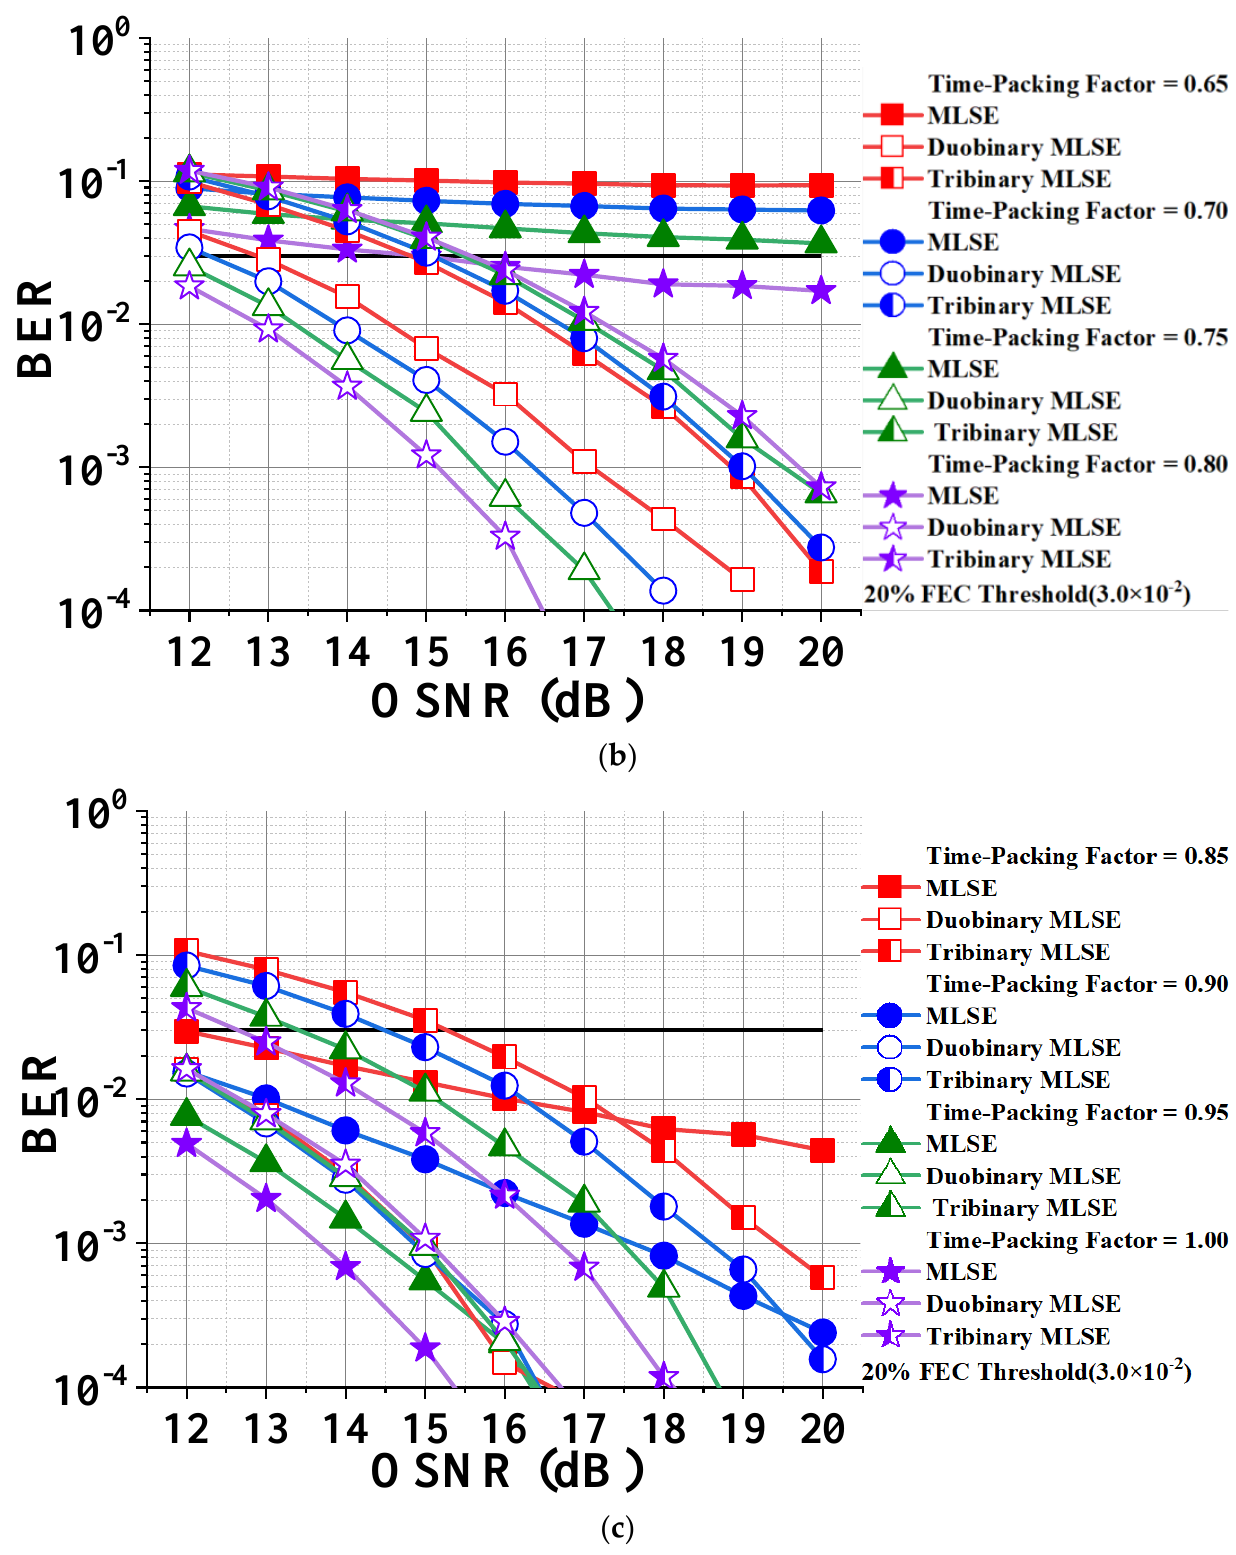
Figure 6. The performance of OSNR versus BER for MLSE, duobinary MLSE and tribinary MLSE under different time-packing factors: ( a ) the time-packing factor changes from 0.45 to 0.60; ( b ) the time-packing factor changes from 0.65 to 0.80; ( c ) the time-packing factor changes from 0.85 to 1.00.